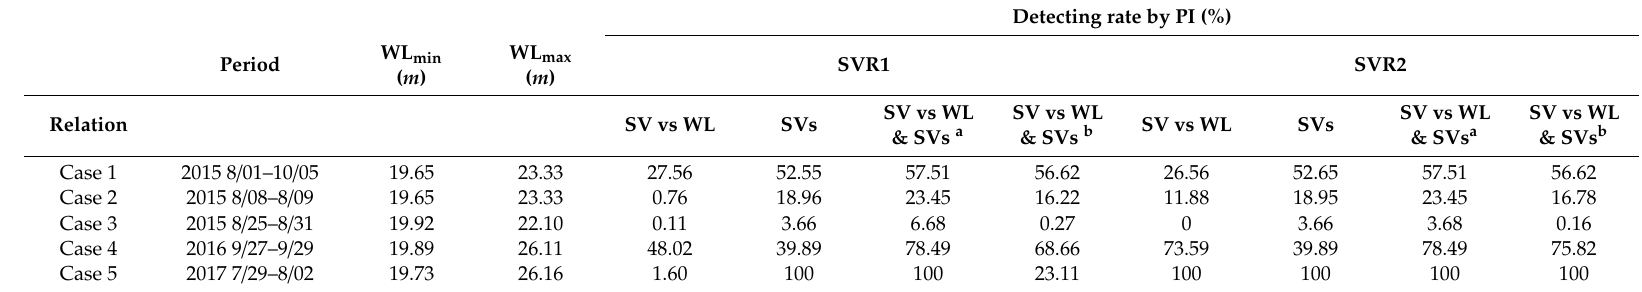
Table 6. Results of detection rate for di ff erent events during 2015–2017 at Yenfong Bridge.